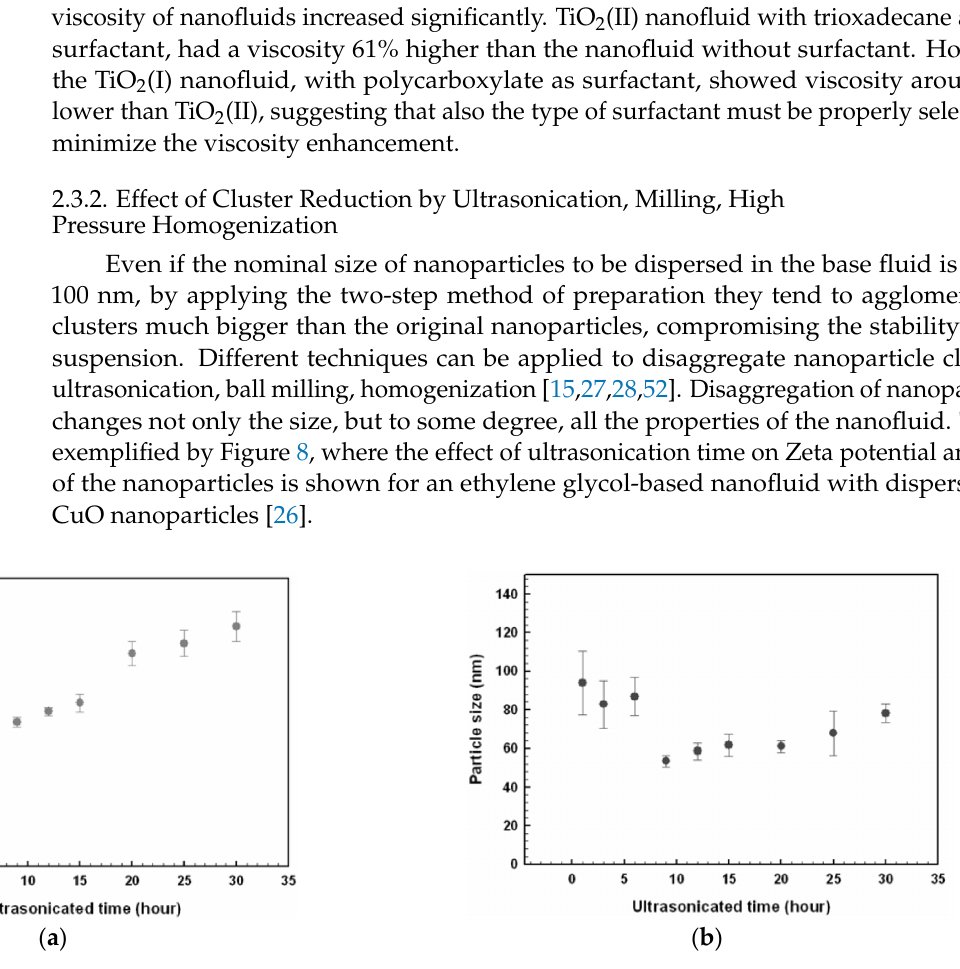
Figure 8. Effect of ultrasonication time on ( a ) Zeta potential value and ( b ) nanoparticle size [26].